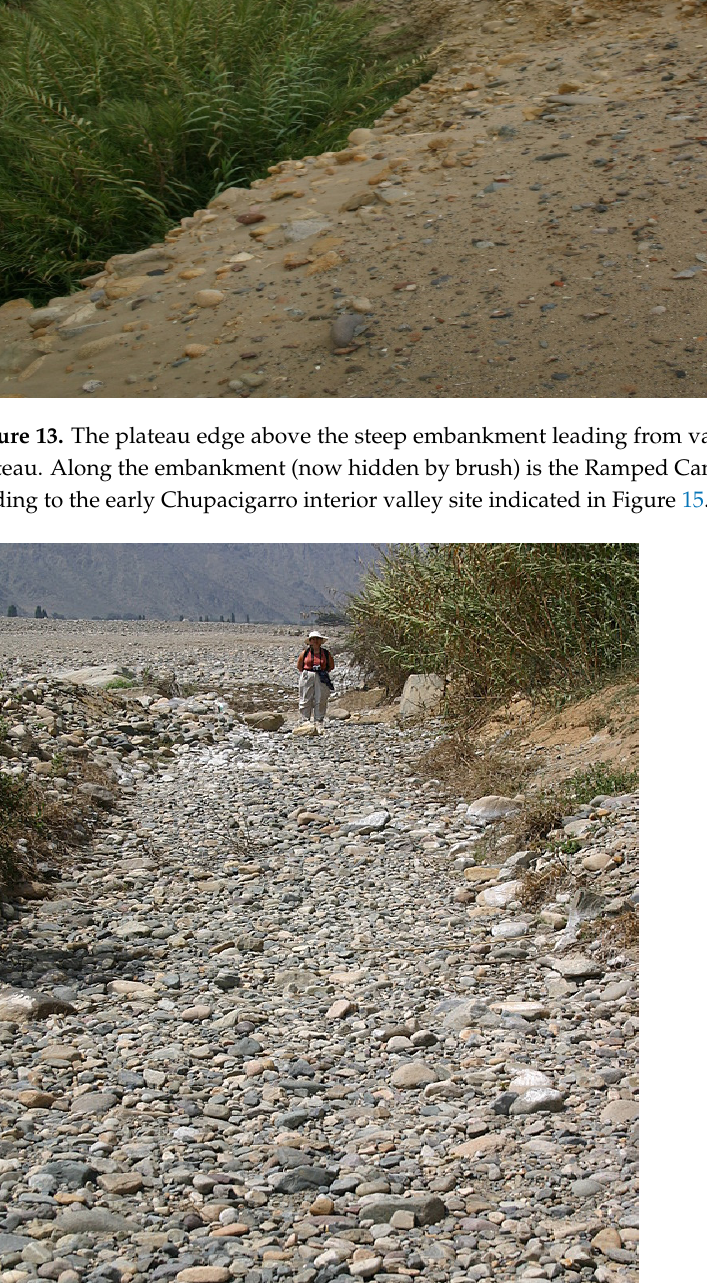
Figure 15. Path of the Ramped Canal to the Chupacigarro site. Current agricultural (brown and black) areas extend to both sides of the Supe River. Figure 14 and the current figure show the canal inlet (A) located in the far upstream reaches of the Supe River. The notation B denotes Early Form- ative Period sites; C and D canals supplied the early site of Chupacigarro located at (red) F. The E and G locations are modern in-use bottomland fields irrigated by high groundwater levels.